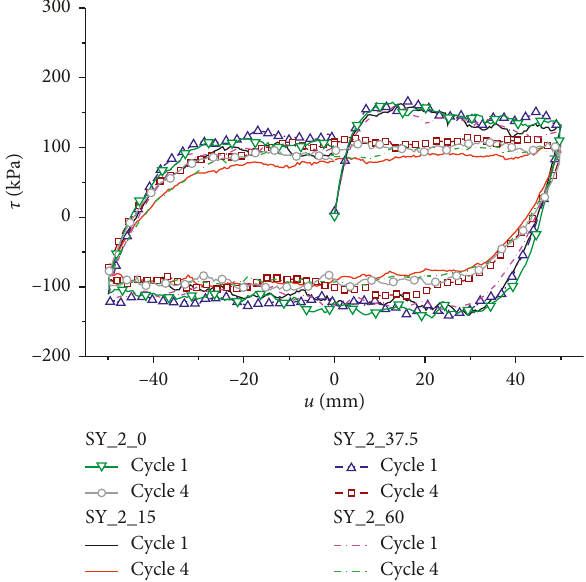
Figure 8: Comparison of the composite pattern group of DEM simulation results in terms of shear displacement against shear stress in Cycle 1 and Cycle 4.